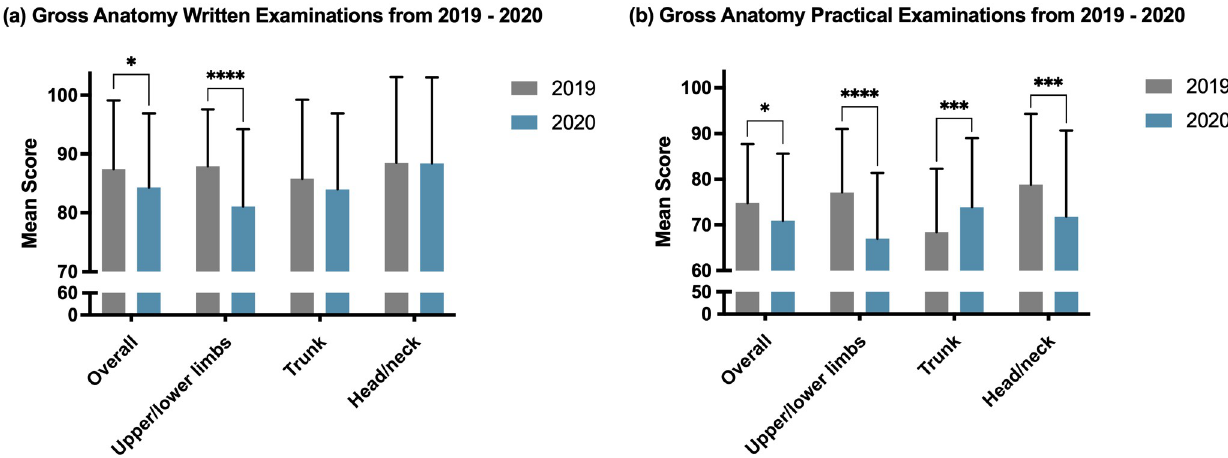
Fig 2. Comparison of written and practical examination scores between 2019 and 2020 at SNUCM. The 2020 schedule of anatomy education was modified because of COVID-19. (a) Students’ performance was assessed using three sets of written examination on three regional units: the upper and lower limbs, trunk, and head and neck. (b) Students’ performance was assessed using three sets of practical examination on three regional units: the upper and lower limbs, trunk, and head and neck. The statistical significance is expressed with the following symbols: � p < 0.05, �� p < 0.01, ��� p < 0.001, ���� p < 0.0001 to indicate statistical differences. Abbreviation: COVID-19 = coronavirus disease 2019, SNUCM = Seoul National University College of Medicine.